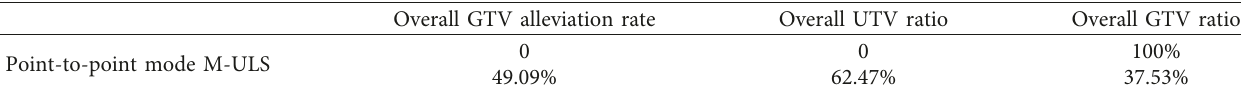
Table 4: Overall variation of traffic